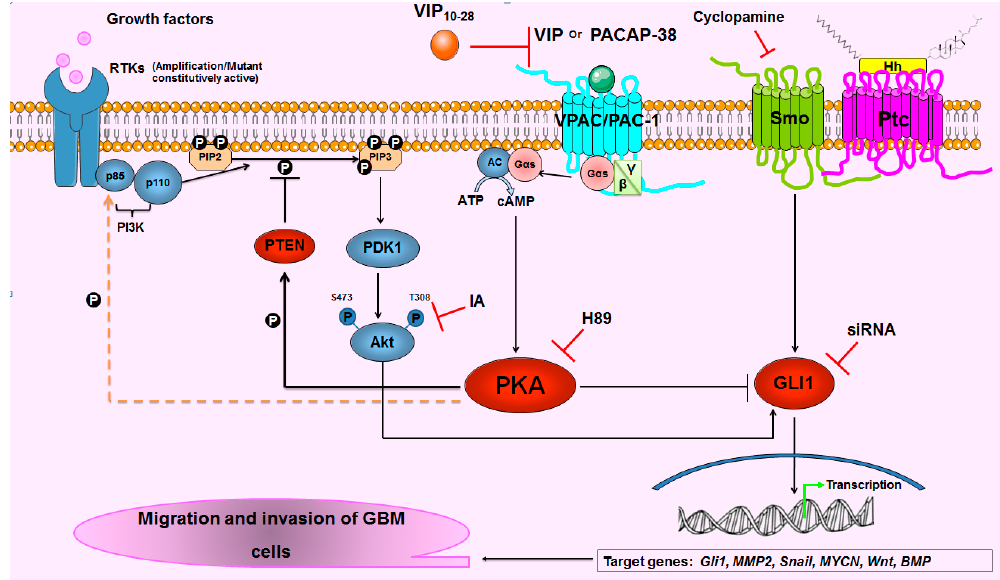
Figure 6. Potential molecular pathways and mechanisms regulated by the VIP-receptor system in glioblastoma (GBM) cells. Binding of VIP and related peptide agonists to their G-protein coupled receptors (GPCR) VPAC-1/2 and PAC1, leads to adenylate cyclase (AC) and cAMP-dependent Protein Kinase (PKA) activation. PKA is a central enzyme in these mechanisms because it could potentially: (i) inhibit glioma-associated oncogene homolog 1 (GLI1) nuclear translocation and activity; (ii) phosphorylate the phosphatase tensin-homolog deleted on chromosome ten (PTEN) and activate its Phosphatidylinositol (3,4,5)-trisphosphate (PIP3) phosphatase activity, leading to an inhibition of Akt phosphorylation and activation and consequently to a reduced nuclear localization and transcriptional activity of GLI1; (iii) phosphorylate the p85 regulatory subunit of PI3K on its serine residue 83. This hypothetic process (dashed line) that was described in vitro and in vivo to play a major role on G1 cell cycle arrest (see the discussion section) remains however to be demonstrated in GBM. Hh: Sonic Hedgehog; Ptc: Patched, the Hh receptor; RTK: receptor tyrosine kinase; Smo: smoothened, the Ptc